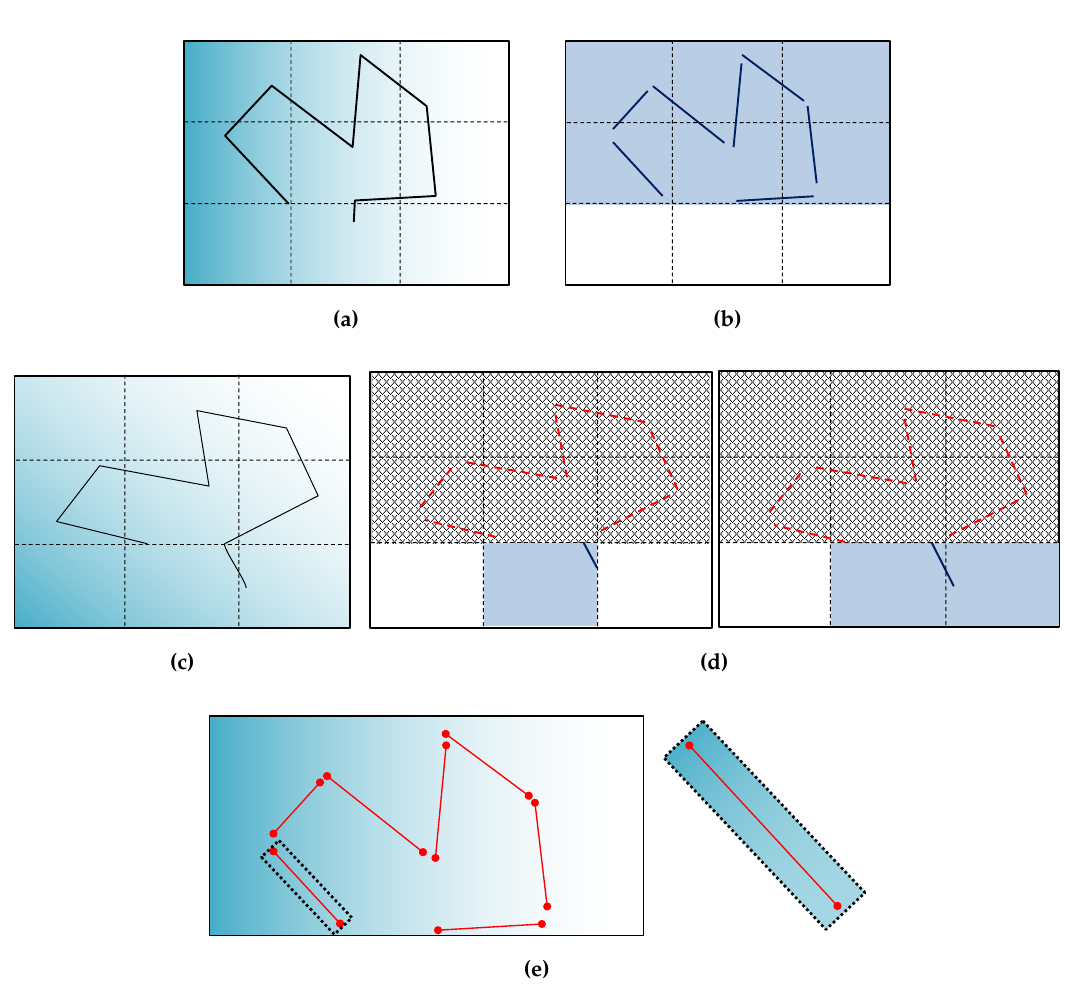
Figure 7. Line detection process. ( a ) Initial image divided in a 3 3 grid of cells. ( b ) Line segments × detected. Only the ones that are longer than a threshold are selected. The cells that contain them are marked as “occupied”. ( c ) Later image of the sequence. The map already contains line landmarks. ( d ) Existing landmarks are projected into the image, and the occupation grid is updated. Occupied grids are marked with a textured pattern. The first image also shows the randomly-selected empty cell and the segment detected on it. The second image shows the result of extending the detected segment. Cells occupied by this segment are colored in blue. ( e ) Appearance of the detected lines. Each line is parametrized by its end points, the pixels surrounding the line are used for